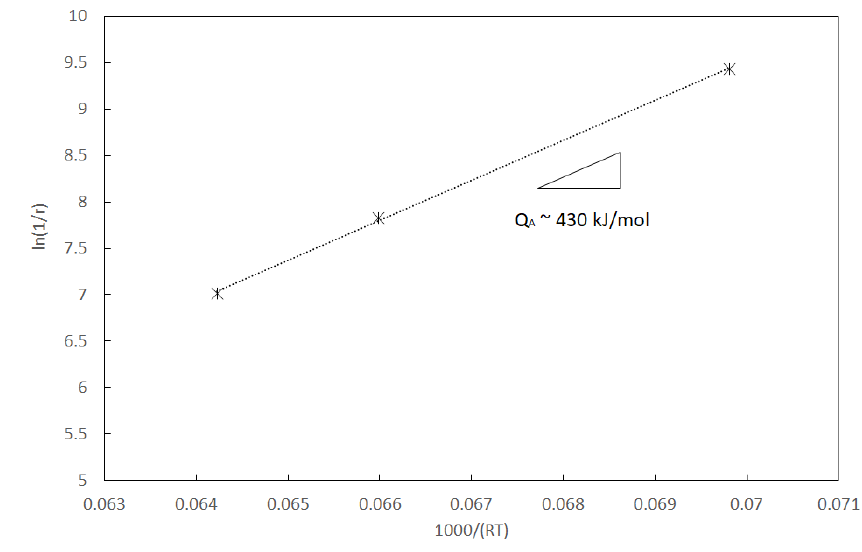
Figure 10. Arrhenius plots of the recovery parameter